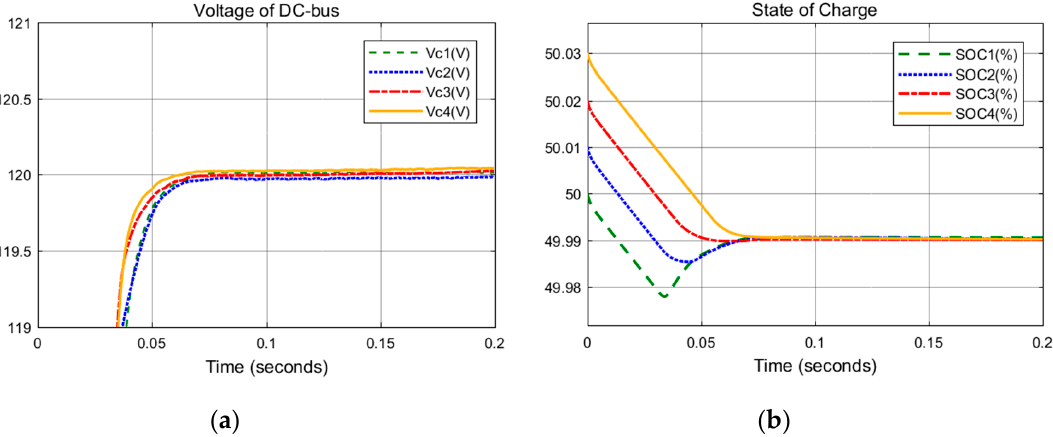
Figure 12. Distributed cooperative control when communication weights a ij = 5: ( a ) DC-bus voltage; ( b ) battery SOC.